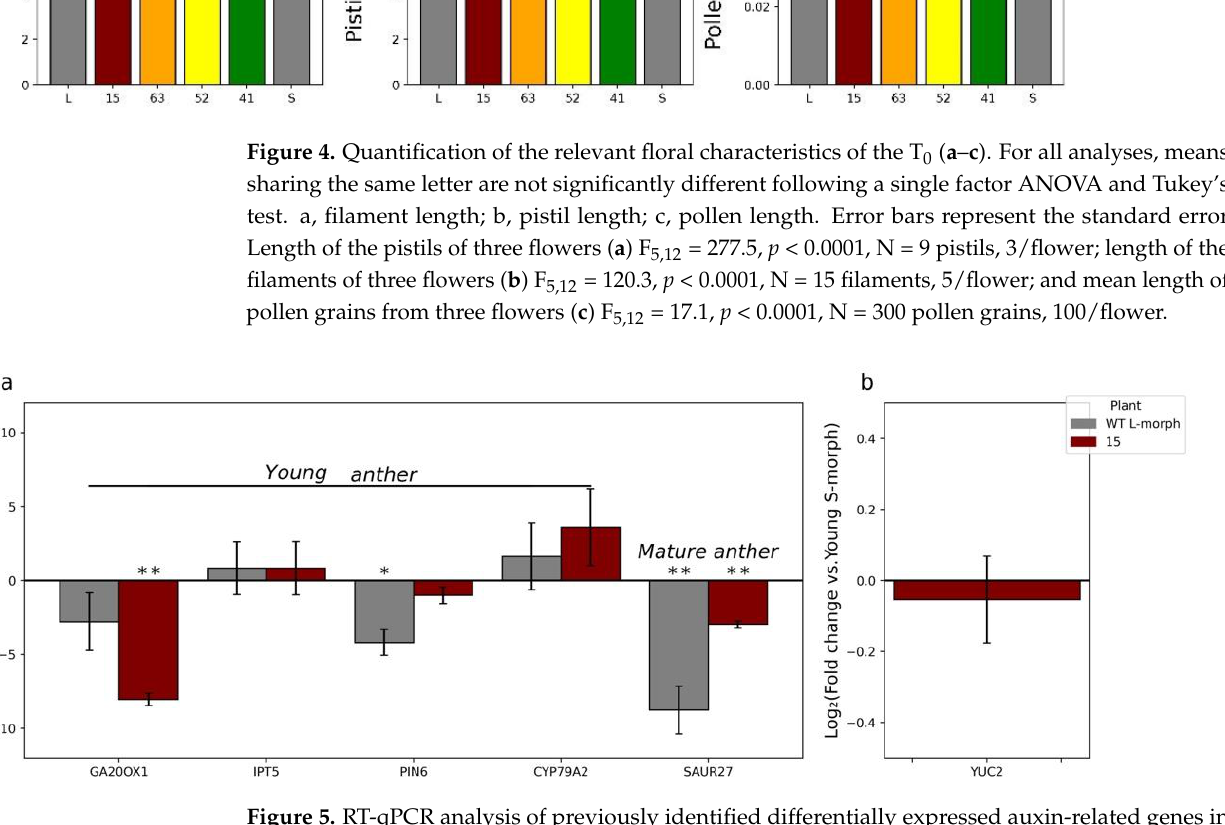
Figure 4. Quantification of the relevant floral characteristics of the T 0 (a-c). For all analyses, means sharing the same letter are not significantly different following a single factor ANOVA and Tukey’s test. a , filament length; b , pistil length; c , pollen length. Error bars represent the standard error. Length of the pistils of three flowers (a) F5,12=277.5, P<0.0001, N = 9 pistils, 3/flower; length of the filaments of three flowers (b) F 5,12 =120.3, P<0.0001, N = 15 filaments, 5/flower; and mean length of pollen grains from three flowers (c) F 5,12 = 17.1, P < 0.0001, N = 300 pollen grains, 100/flower.